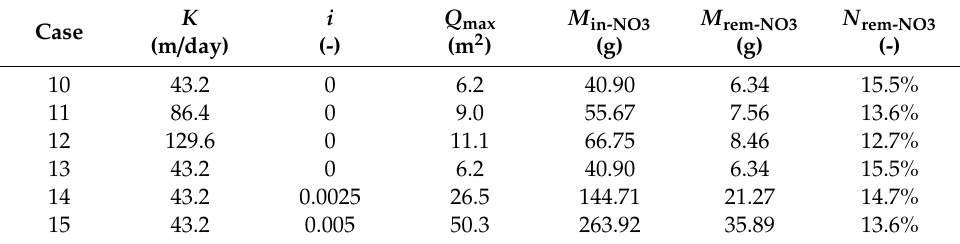
Table 5. Q max , M in-NO3 , M rem-NO3 and N rem-NO3 under di ff erent hydrogeological